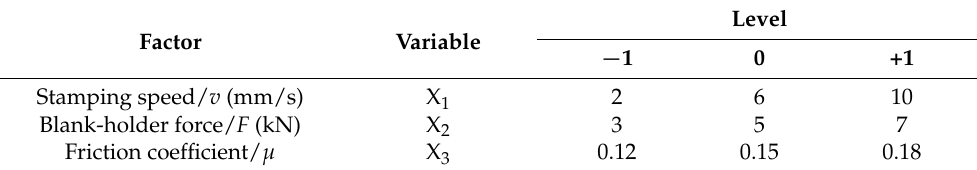
Table 3. Factors and levels for hot-stamping